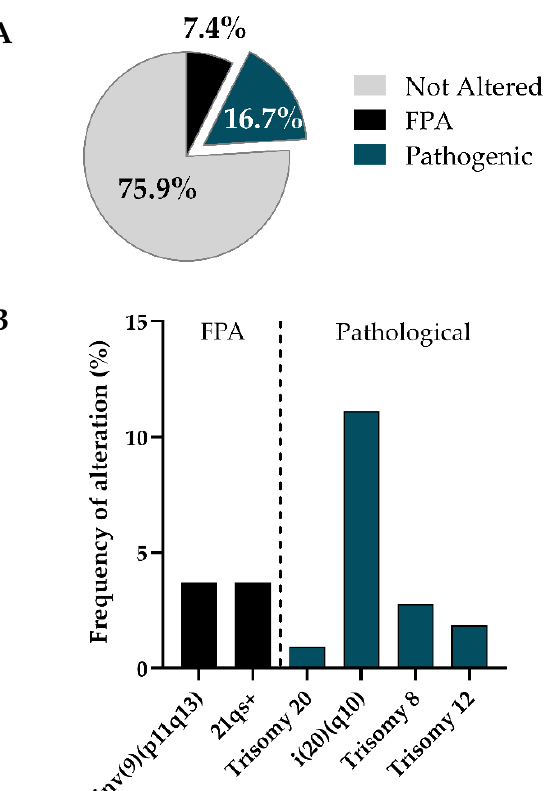
Figure 3. Recurrent karyotypic aberrations are detected in cultured hPSCs by G-banding: ( A ) Pie chart of fraction of genomic alterations detected with karyotype on the total of the cell lines analyzed; ( B ) histogram of chromosomal abnormalities found in hPSCs by using karyotype. Each bar represents the percentage of time that the alterations has been found in hPSCs. FPA: Frequent Polymorphic Alterations.